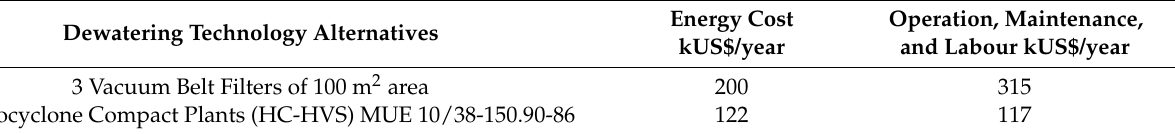
Table 3. Opex Comparison between vacuum belt filter plant and HC-HVS plant at Mantos Blancos Project [32].